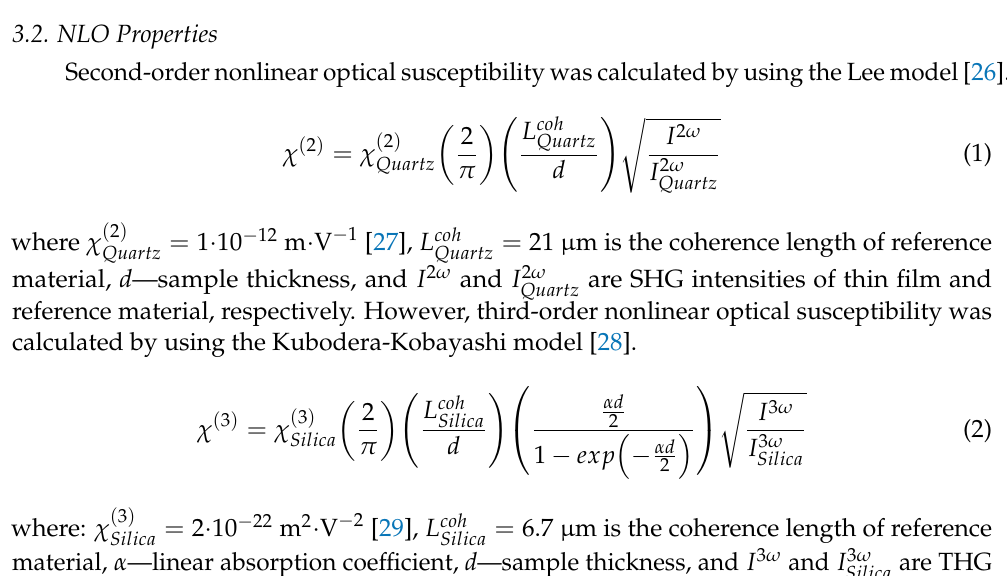
Figure 5. Changes in the absorption spectra of P1 in tetrahydrofuran (THF) before (1) and after 5 s period (2) 8 s (3), 12 s (3), 16 s (4), 17 s (5), 21 s (6), 25 s (7), 28 s (8), and 33 s (9) irradiation at a wavelength of 365 nm at room temperature.